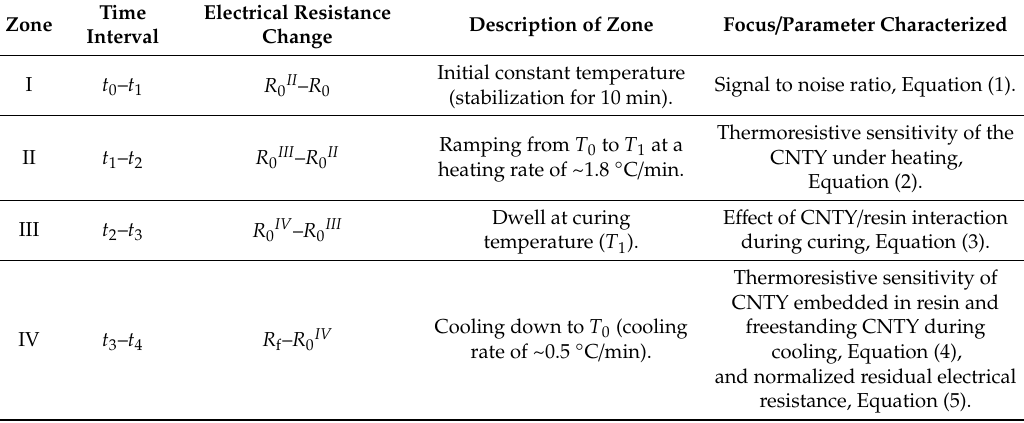
Table 2. Summary of zones and parameters characterized for CNTY/ER-A and CNTY/ER-B.